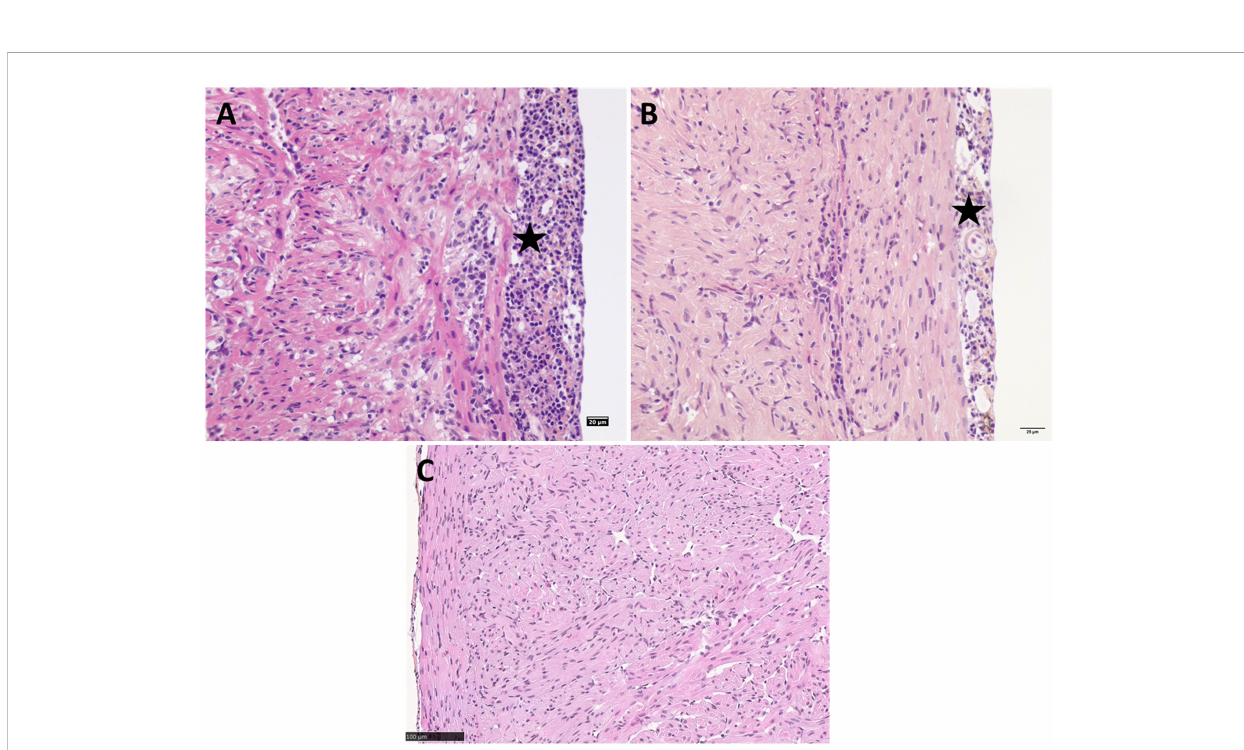
FIGURE 7 PRV-1 challenged Atlantic salmon post-smolts heart ventricle showing severe epicarditis and myocarditis in the compact and spongy myocardium (A) Cohabitation challenge at 10 WPI (B) IP challenge at 8 WPI. (C) Noninfected control Atlantic salmon post-smolt heart ventricle at 8 WPC. Stars highlight